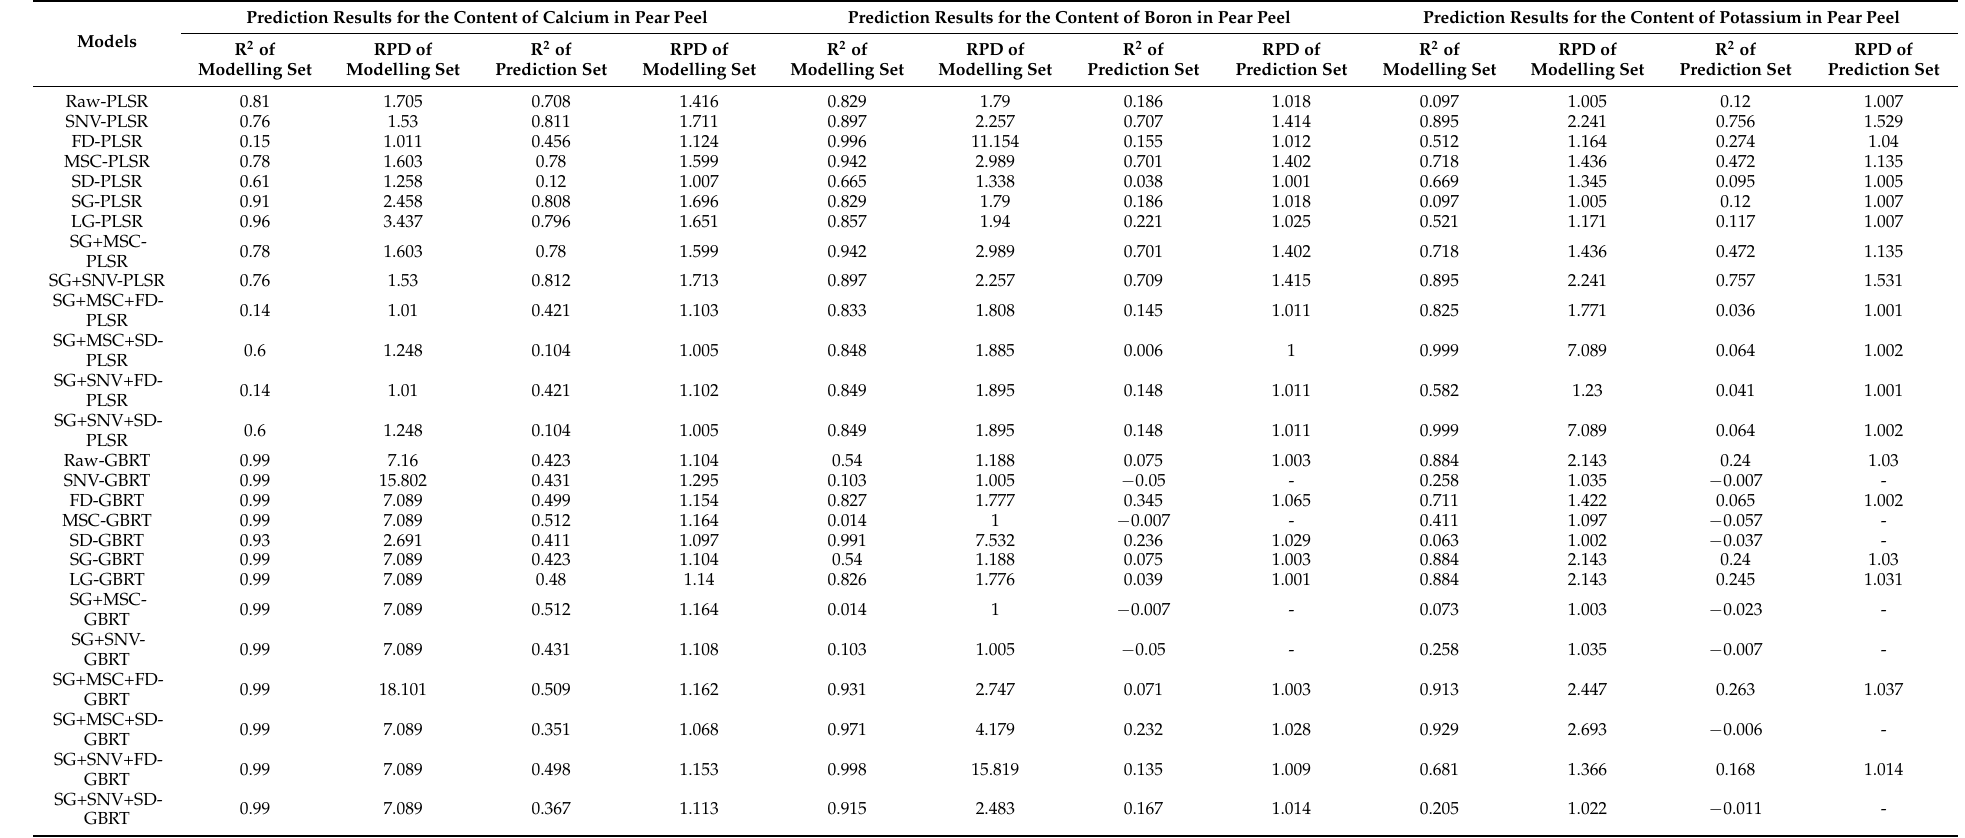
Table 6. Comparison of the prediction and modelling sets for the content of calcium, boron and potassium in pear peel based on full-wave